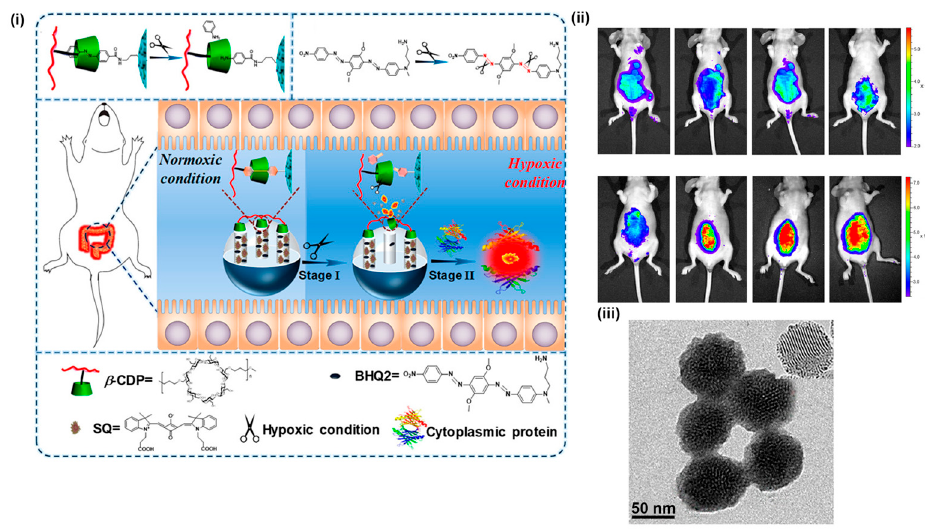
Figure 9. HCFA-MSNs. ( i ) A schematic illustration of hypoxia-activatable and cytoplasmic protein-powered fluorescence cascade amplifying (HCFA) MSNs. The HCFA-MSNs are composed of the β -cyclodextrin polymer ( β -CDP) gatekeeper, loaded with both squarylium (SQ) dyes and black hole quencher 2 (BHQ2). ( ii ) In vivo fluorescence images of nude mice after the injection of a commercial small molecular fluorescent probe, the HCFA-MSNs, the control group or convalescent group of the HCFA-MSNs (from right to left), respectively. The most intense fluorescent signal can be observed the HCFA-MSNs. ( iii ) TEM image of the as-synthesised MSNs. Adapted with permission from Ref. [124]. Copyright (2020) American Chemical